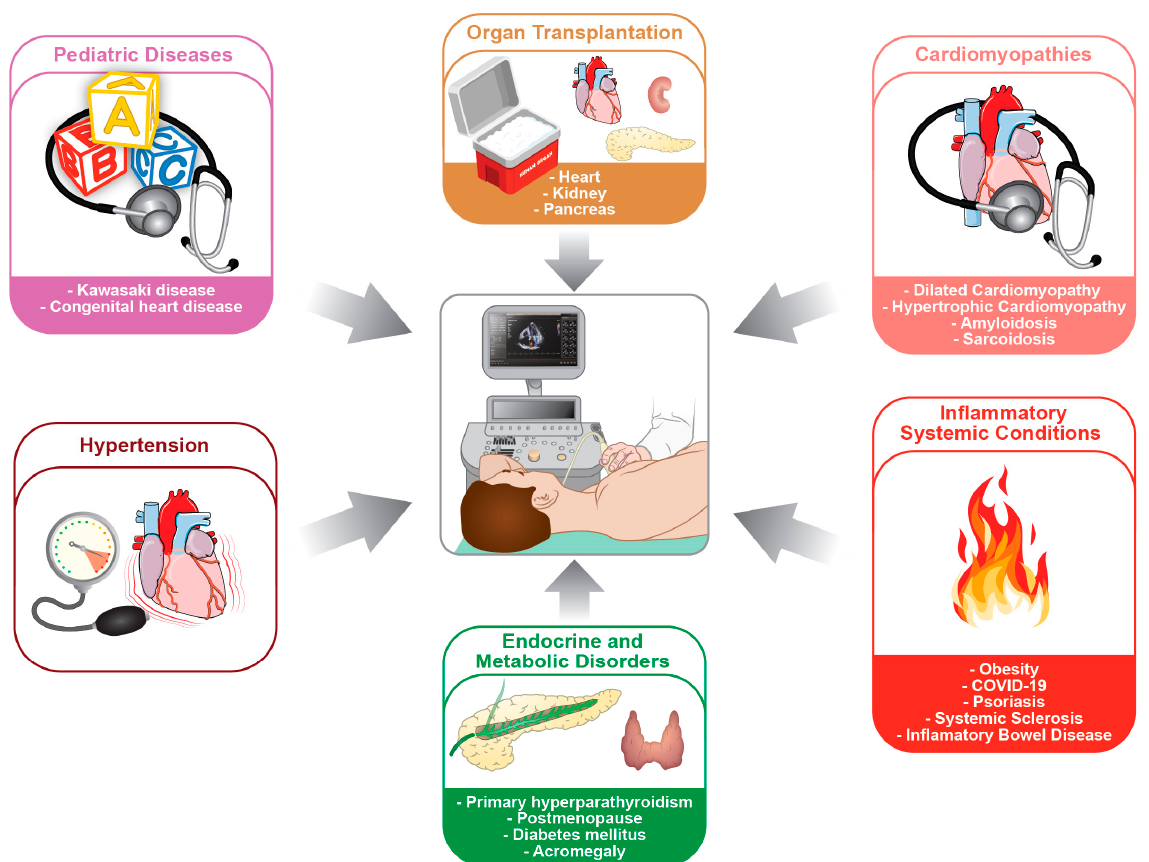
Figure 1. Measurement of coronary flow reserve (CFVR) by transthoracic Doppler echocardiography (TTDE) was proven to be a reliable tool with which to investigate coronary microvascular function in many cardiac and systemic diseases. Although initially developed to assess the hemodynamic relevance of an epicardial coronary stenosis, the study of CFVR by TTDE during the last 30 years expanded to a variety of different medical conditions, from organ transplantation to metabolic and inflammatory disorders and from cardiomyopathies to pediatric diseases.